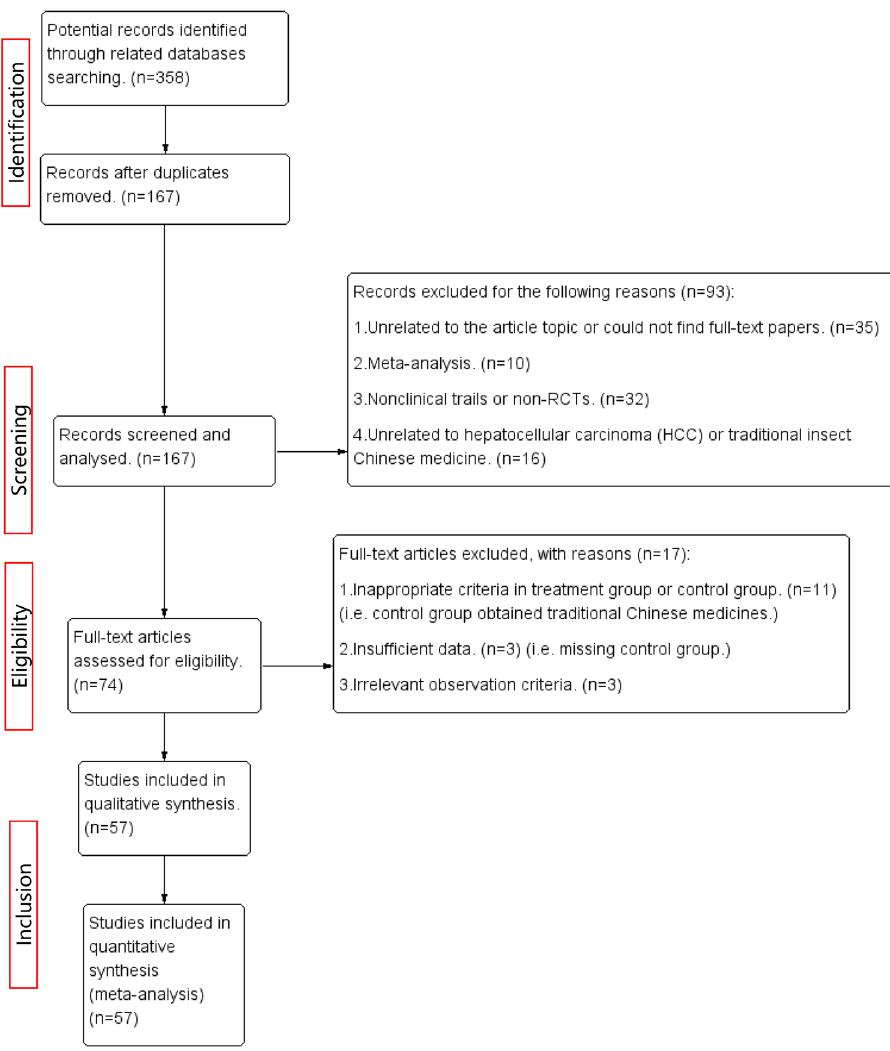
Figure 1. The Preferred Reporting Items for Systematic Reviews and Meta-Analyses (PRISMA) Flow